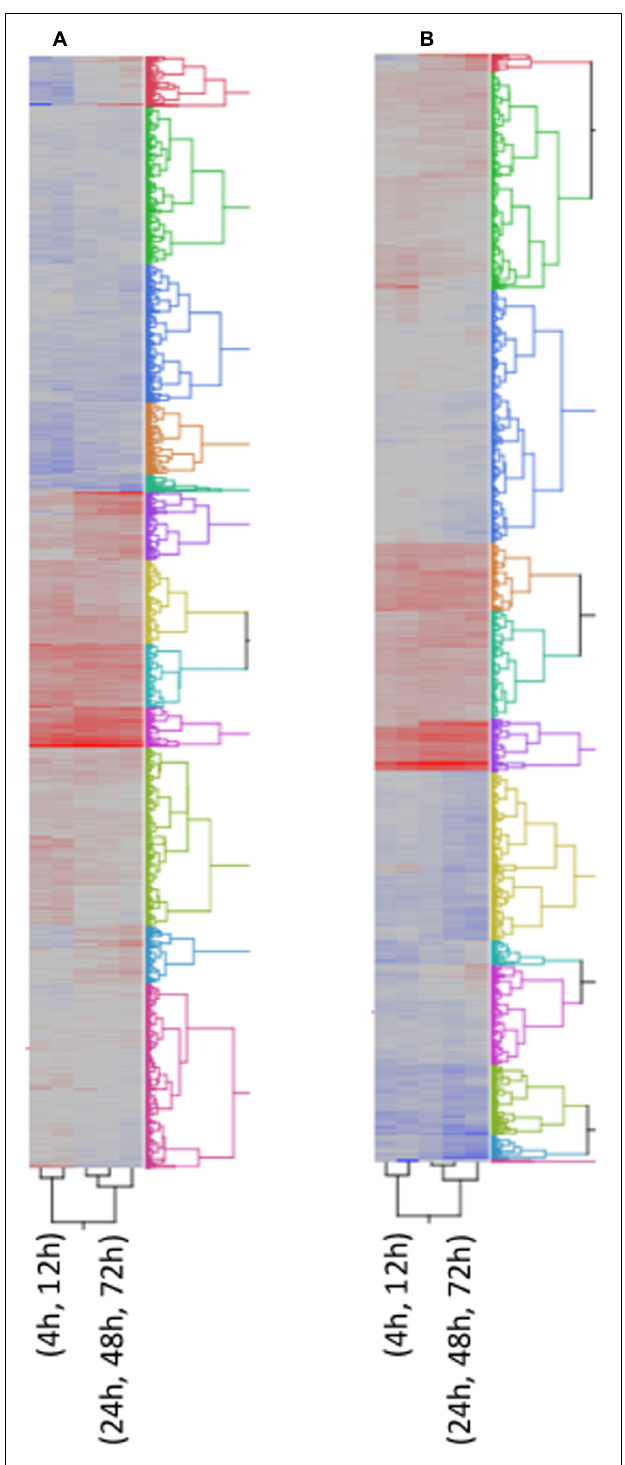
FIGURE 4 | Two way Clustering of differentially expressed genes. FPKM values of differentially expressed genes were Ln transformed and Ward’s Hierarchical Clustering was performed. The number of clusters was set at 12 and clusters were color coded. The color map indicates relative gene expression over time with red indicating high expression and blue indicating low expression. (A) A. flavus ; (B) F. verticillioides